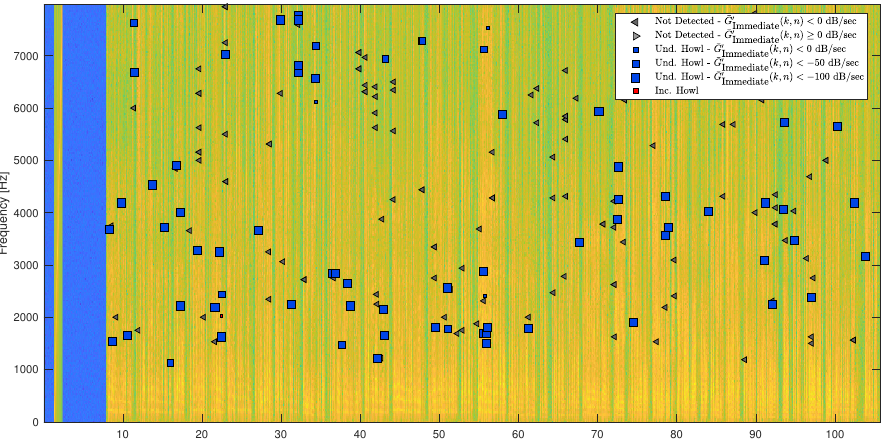
Figure 7. Spectrogram of the devised input signal and the united retrospectively detected howling artifacts. Considering the Soft MSD-based with FA Detection detector, increasing howls are colored red; underdamped howls are colored blue and separated by their magnitude slope; and undetected frequency-howls are colored in shades of gray and marked with arrows to indicate the slope of the suspected